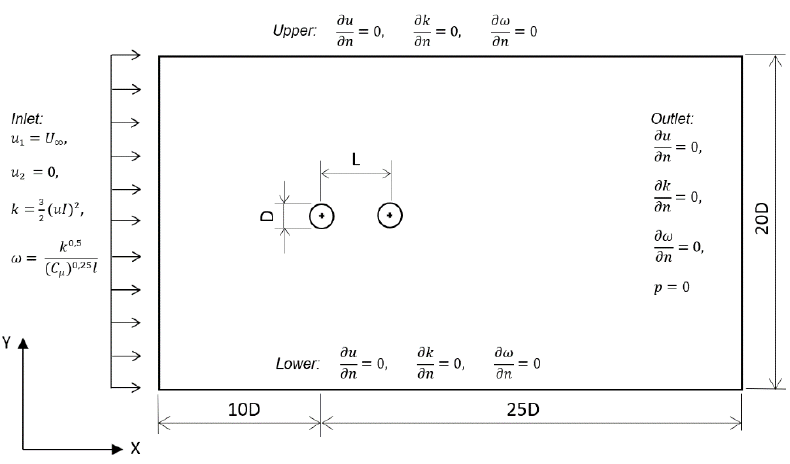
Figure 1. The computational domain for the tandem cylinders.